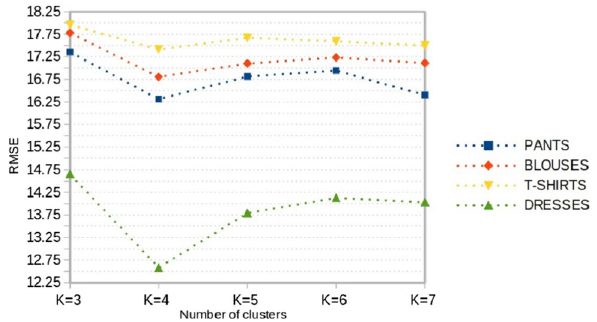
Fig. 7 Root mean squared error obtained by cross-validation accord- ing to the number of